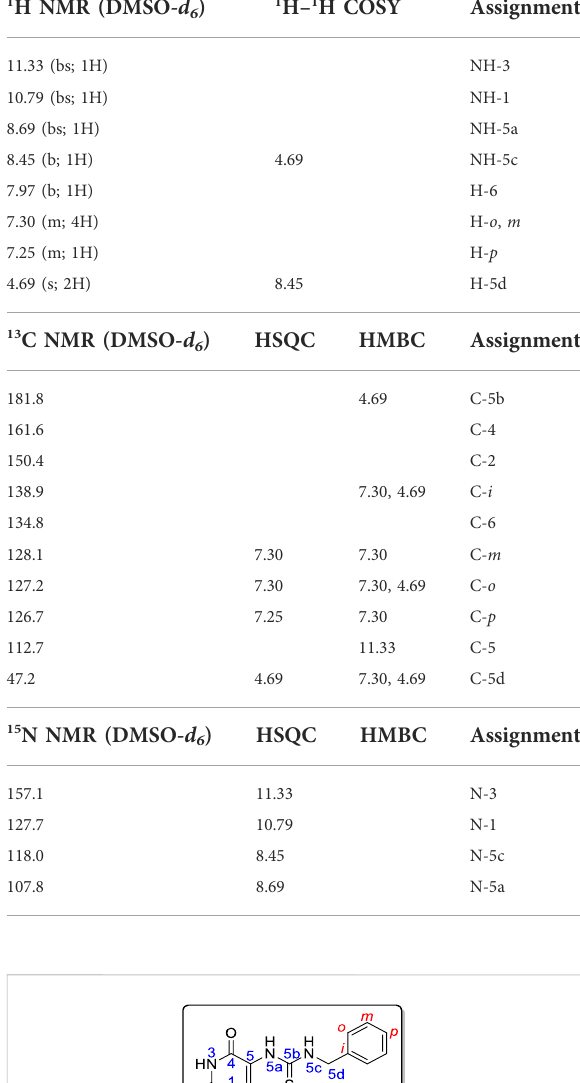
TABLE 2 NMR spectroscopy of compound